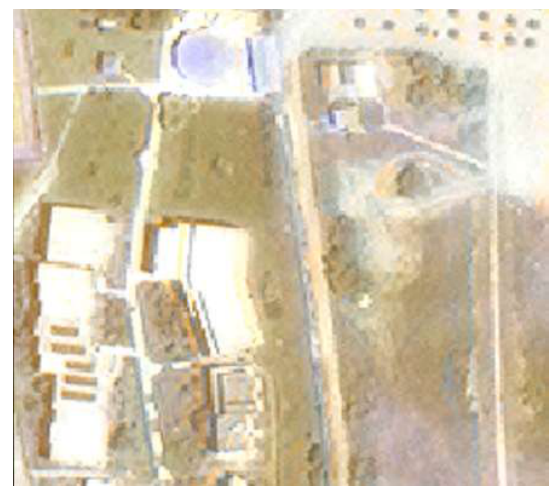
Figure 1. QuickBird image of “Scene 1” at spatial resolution 30cm/pixel.